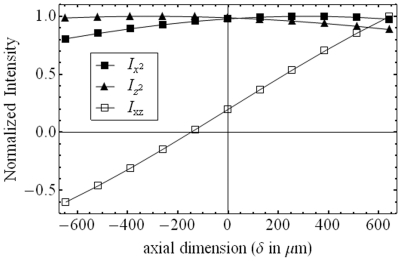
Normalized intensity axial dependency.Intensities ,  and  from eqs. 14 & 15 show peaks for and occur at different axial positions.